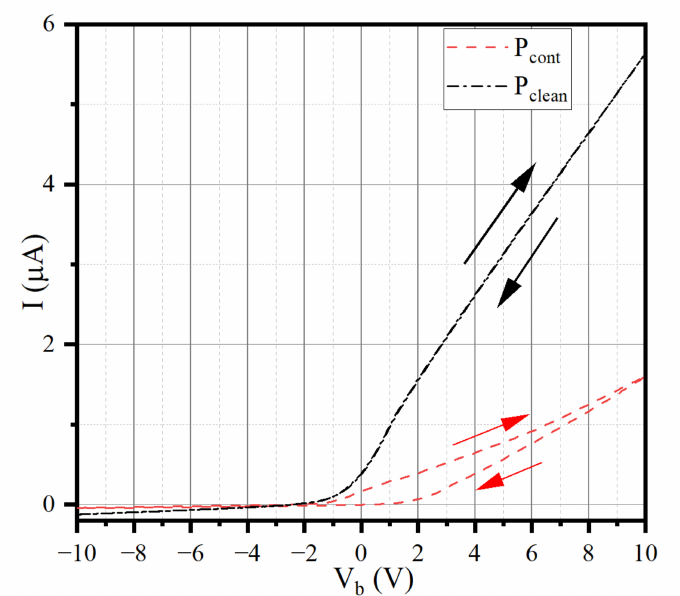
Figure 2. Comparison of I-V characteristic curves collected by contaminated probe and clean